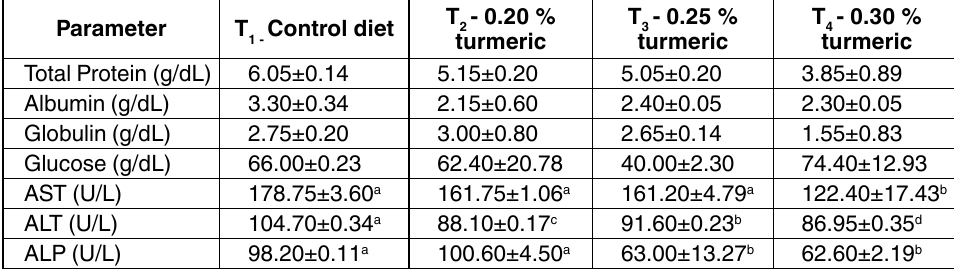
Table 5. Effect of turmeric powder on serum biochemical of broiler chickens